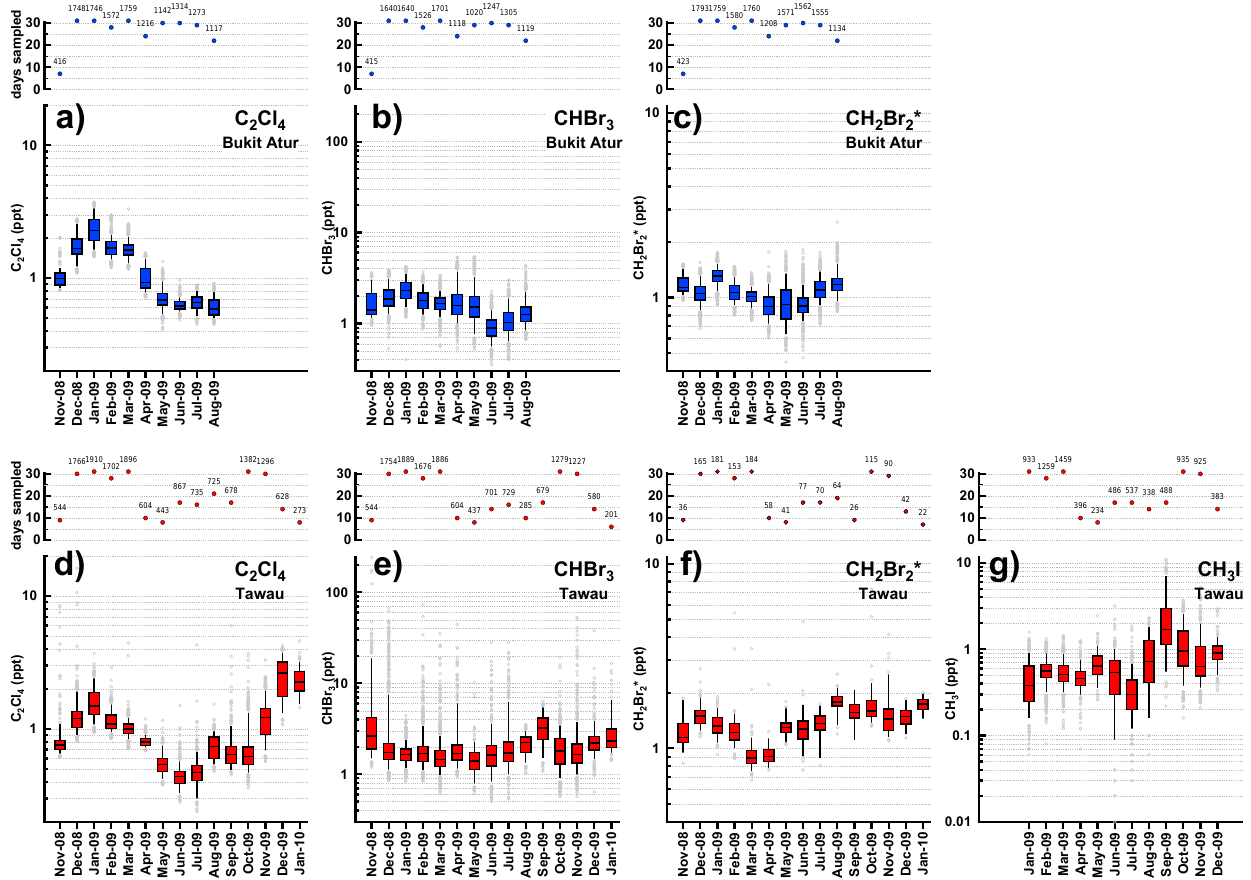
Figure 4. Box-and-whisker plots for the halocarbon observations at Bukit Atur for (a) C 2 Cl 4 , (b) CHBr 3 and (c) CH 2 Br ∗ and at Tawau 2 for (d) C 2 Cl 4 , (e) CHBr 3 , (f) CH 2 Br ∗ and (g) CH 3 I. In each panel, the coloured boxes show the data falling between the 25th and 75th 2 percentiles, with the median value shown as a black horizontal line inside each box. The vertical black lines above and below each box indicate the 95th and 5th percentiles respectively. Outliers (values beyond the 95th and 5th percentiles) are shown as grey open circles. The mixing ratio ( y axis) scale is logarithmic in order to show the extreme high values, such as for CHBr 3 at Tawau (e) . The filled circles in the smaller panel above each box-and-whisker plot show the number of days sampled each month, and labels indicate the number of samples used to generate each box and whisker. The total sample count is different at each site due mainly to different periods of instrument downtime and differences in the sampling frequency at each